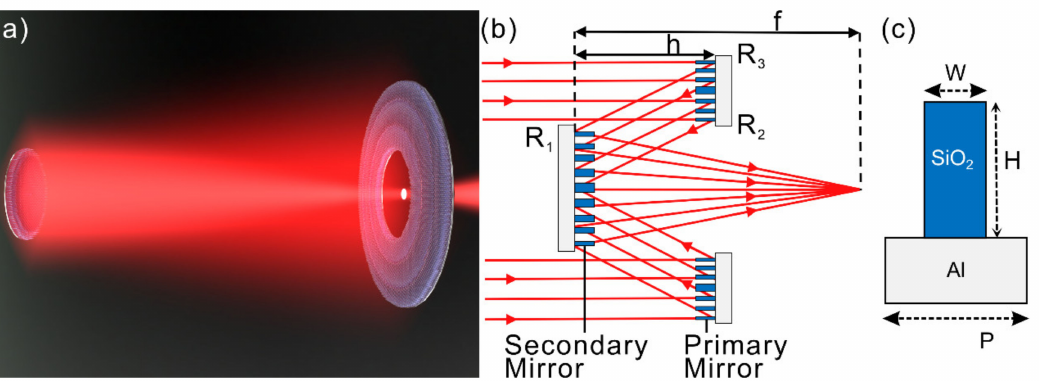
Figure 1. ( a ) Schematic illustration of a Cassegrain telescope based on reflective metasurfaces. ( b ) Schematic drawing of the optical path as well as the design parameters of the metasurface Cassegrain telescope, including R 1 , R 2 , R 3 , h and f. ( c ) Meta-atom of the metasurface, which consists of an SiO 2 stripe on top of an Al mirror. Period, width and height of SiO 2 stripe are labeled as P, W and H,